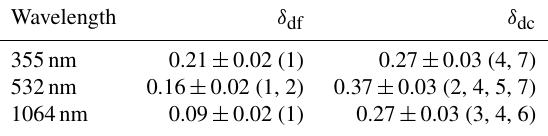
Table 1. Typical fine and coarse dust linear depolarization ratios, δ df and δ dc , respectively, as estimated from published laboratory studies (1: Järvinen et al., 2016; 2: Sakai et al., 2010) and field observations (3: Freudenthaler et al., 2009; 4: Burton et al., 2015; 5: Veselovskii et al., 2016; 6: Haarig et al., 2017a; 7: Hofer et al.,